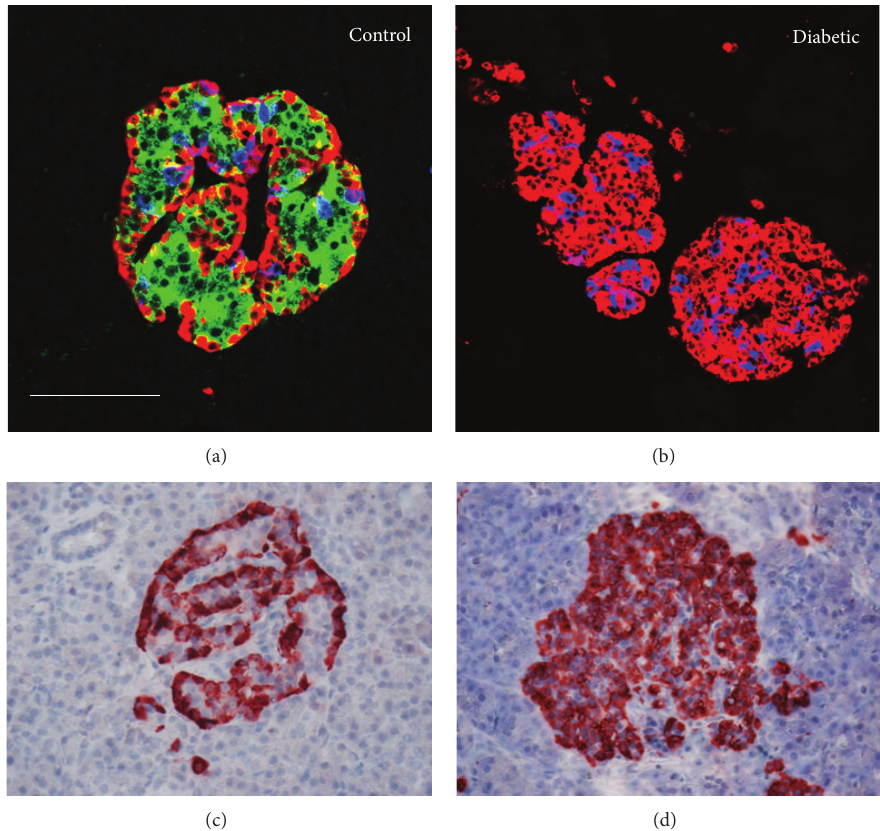
Figure10:Humanisletmorphologyandinfiltration.(a)Anisletfromnondiabetichumandonorwaslargewithanormalcellularmorphology. Scale bar = 100 𝜇 m for both images. (b) An example of an islet from a donor with controlled diabetes showed a lack of 𝛽 -cells. (c) Glucagon staining illustrates the lack of infiltration in the healthy donor. (d) The donor with long-standing diabetes also had no signs of